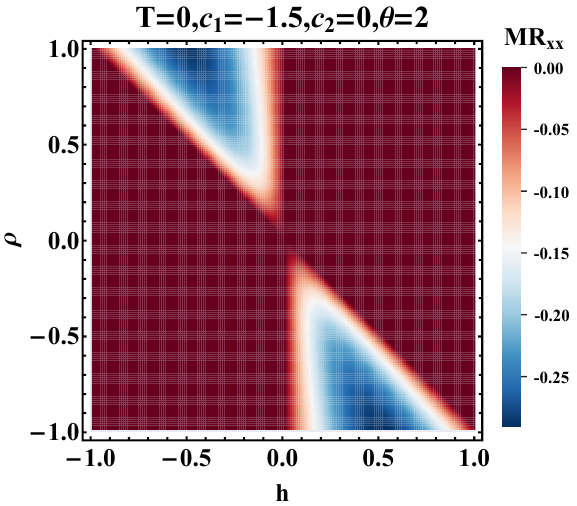
Figure 10 . Negative magneto-resistivity region for θ = 3 in the parameter plane for Maxwell- Chern-Simons electrodynamics at zero temperature. We set c 1 = − 1 . 5 and c 2 = 0